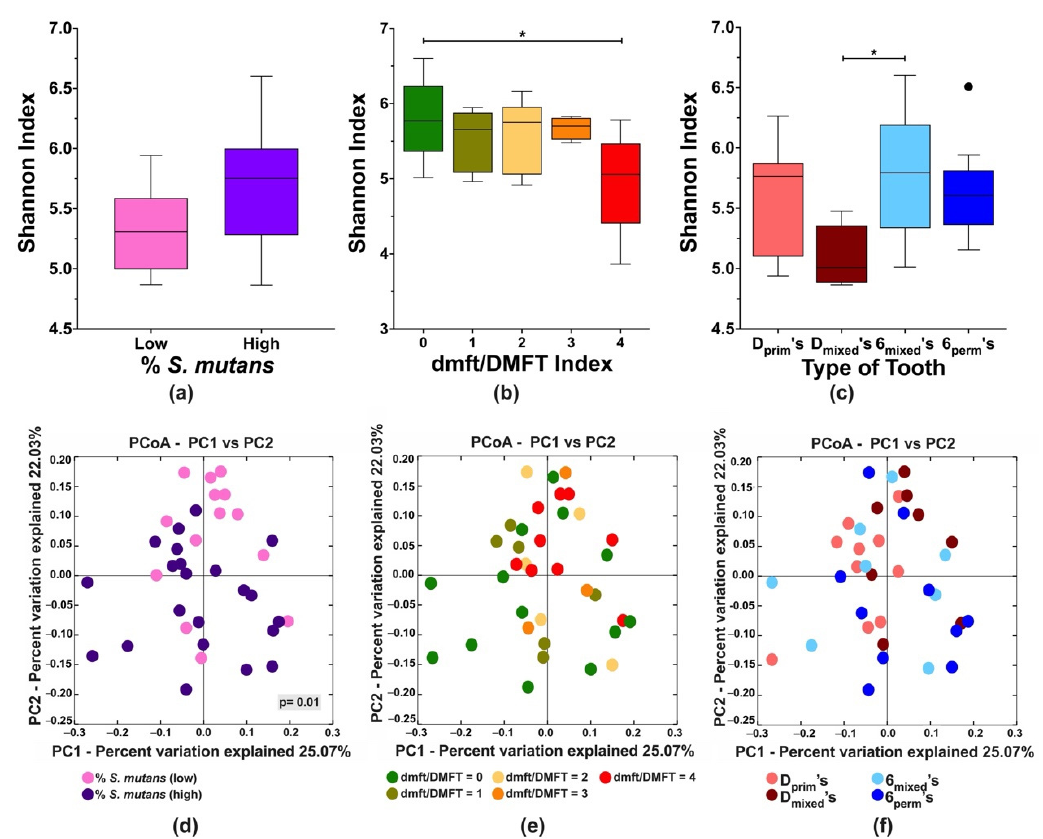
Figure 2. Alpha and beta diversity analyses of the microbial community associated with first primary and permanent molars within the different dentition stages (Dprim’s, Dmixed’s, 6mixed’s, and 6perm’s). Alpha diversity was analyzed using Shannon index (upper panel, ( a – c )), and beta diversity was calculated by principal coordinates analysis (PCoA) of weighted Unifrac distances (lower panel, ( d – f )). The analyses were performed based on the following parameters: ( a , d ) S. mutans levels, low (% < 1%) and high (% ≥ 1%); ( b , e ) posterior tooth dmft/DMFT index; and ( c , f ) tooth type per dentition. The differences in the significance of the groups were performed by one-way ANOVA followed by Kruskal–Wallis multiple comparisons tests; differences in unweighted Unifrac distances between the groups were analyzed with analysis of similarity (ANOSIM); * p < 0.05. The black dot in Figure 2c represents an outlier.